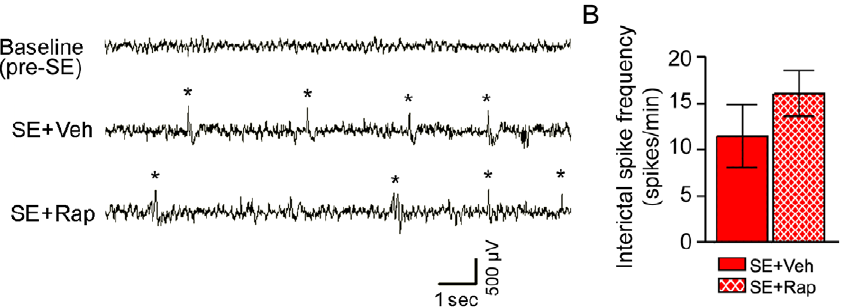
Figure 3. Interictal spike frequency following SE was unaffected by rapamycin. ( A–B ) EEG activity was recorded one week before (baseline) and 2–3 weeks after pilocarpine-induced SE during rapamycin (SE + Rap) or vehicle treatments (SE + Veh). Interictal spikes were quantified from each experimental group. ( A ) Representative EEG traces from cortex show abnormal interictal spike activity (*) in the SE + Veh and SE + Rap groups 2–3 weeks after SE, which is not evident in the baseline EEG trace. ( B ) Quantification of interictal spike frequency showed no differences between SE + Veh and SE + Rap groups. Similar findings were evident in hippocampal EEG traces (data not shown). P . 0.05, Student’s t test; n=7 2 8. Scale bar=500 m V/ sec. Error bars=SEM.